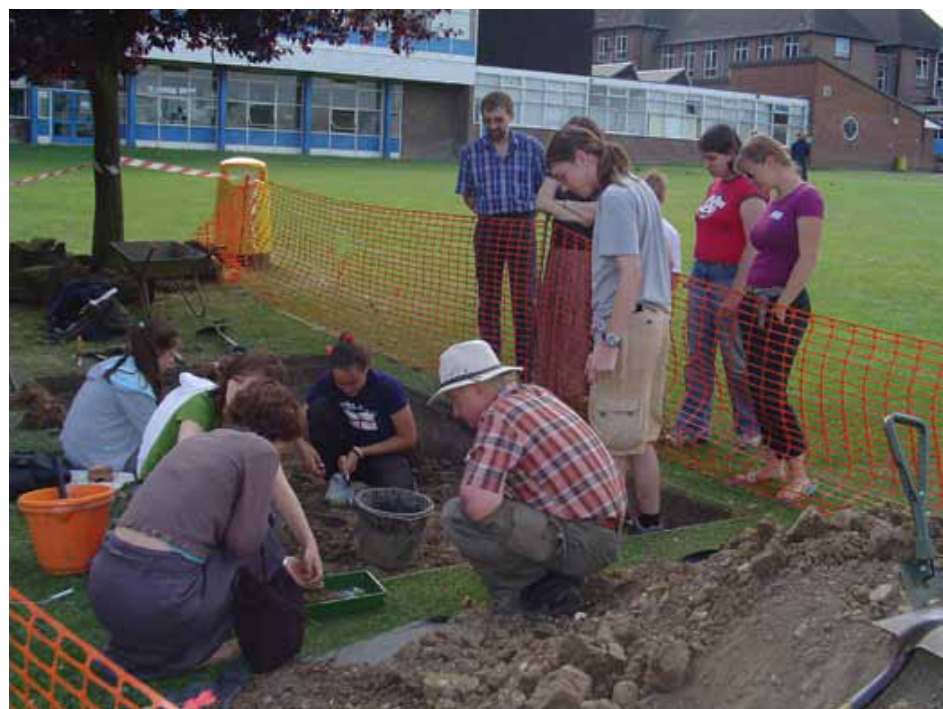
Fig. 1: Andrew Coulson of HADAS and Sarah Dhanjal explaining the site and the finds, at Hendon School, to parents of some of our student